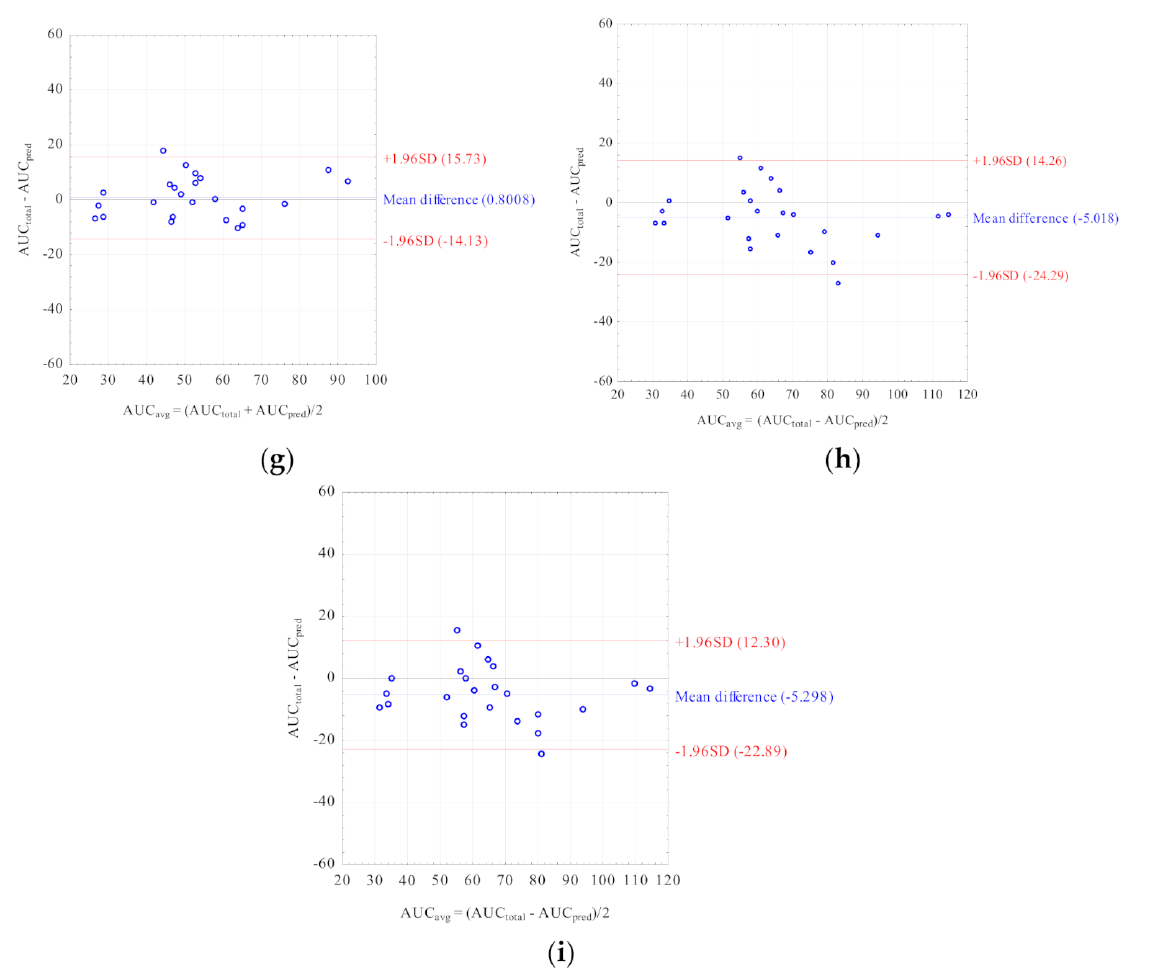
Figure 3. Bland–Altman analyses testing agreement between the MPA AUC total and the MPA AUC pred calculated for children with nephrotic syndrome using the MLR LSS equations found in the literature that fulfilled the criteria for %MPE and %MAE ± 15%; ( a ) AUC pred = 7.4 + 2.3 × C 0 + 1.2 × C 1 + 2.3 × C 3 + 4.4 × C 6 [30]; ( b ) AUC pred = 9.328 + 1.311 × C 1